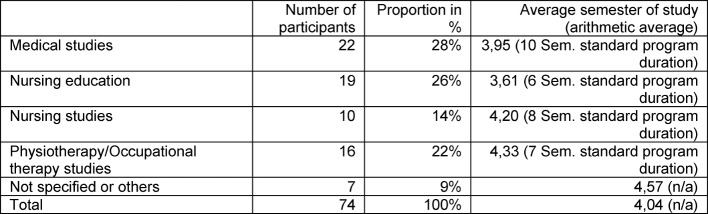
Sample description